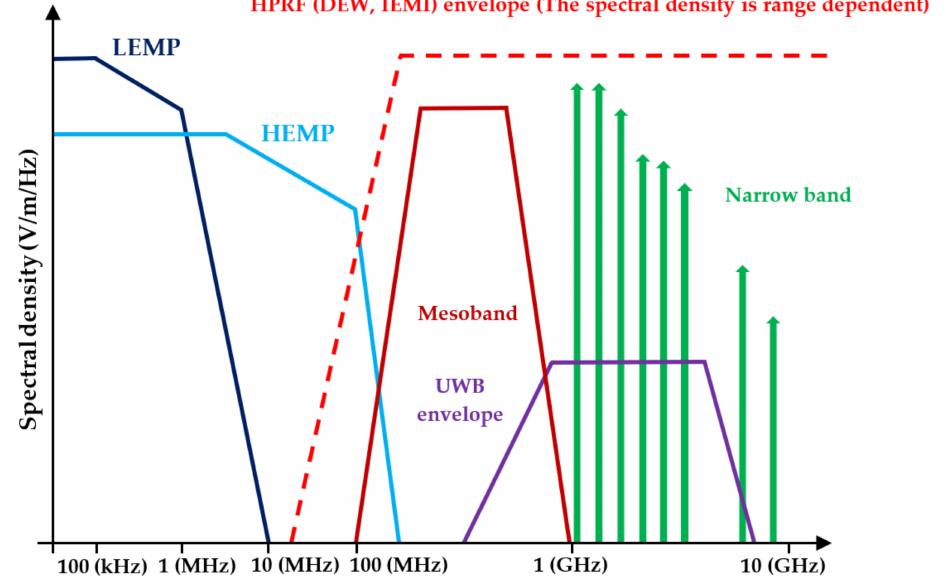
Figure 1. Illustration of the HPEM environment